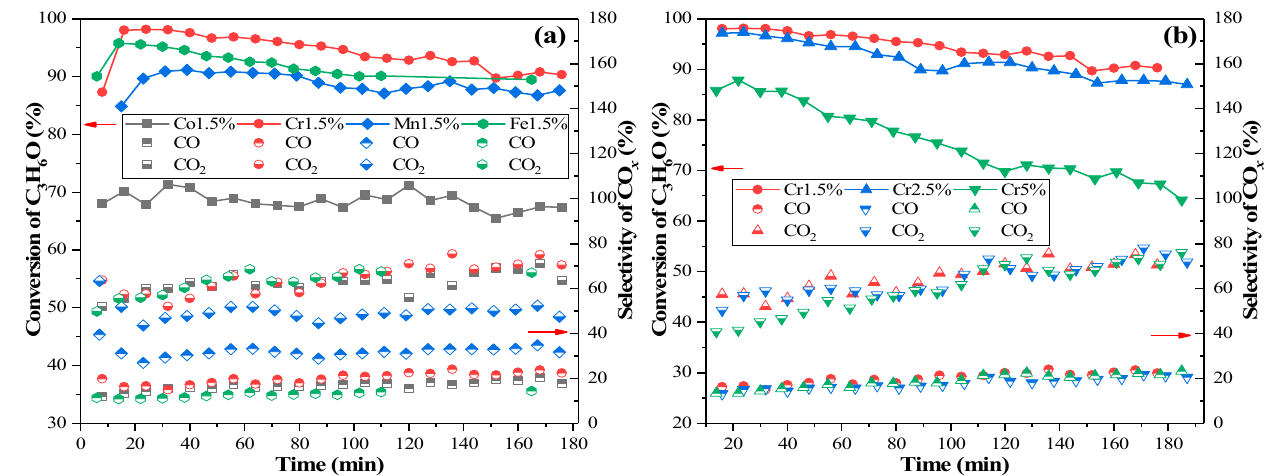
Figure 1. The C 3 H 6 O ozonation conversion efficiencies with different catalysts. ( a ) four catalysts with different active components of transition metal oxides; ( b ) CrO x / γ -Al 2 O 3 catalysts with different Cr loadings. (C 3 H 6 O initial concentration: 30 ppm, O 3 initial concentration: 240 ppm, temperature: 120 °C).